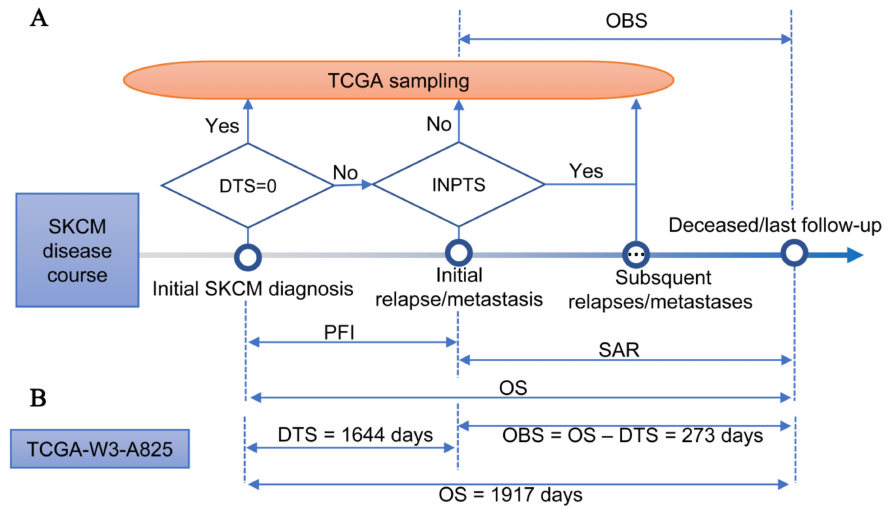
Figure 1. Definition of observed survival interval for TCGA-SKCM cohort. ( A ) Disease course